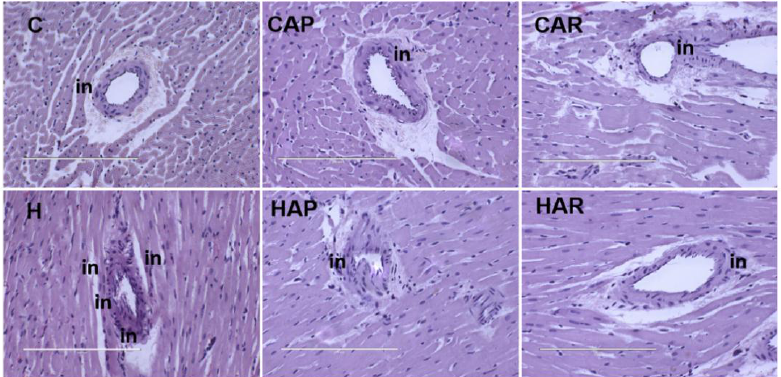
Figure 3. Hematoxylin and eosin staining of left ventricles of heart (magnification × 20; scale bar = 200 µ m) showing inflammatory cells (indicated as “in”) as dark spots outside the myocytes in rats fed corn starch diet (C), corn starch diet + achacha pulp (CAP), corn starch diet + achacha rind (CAR), high-carbohydrate, high-fat diet (H), high-carbohydrate, high-fat diet + achacha pulp (HAP), and high-carbohydrate, high-fat diet + achacha rind (HAR).